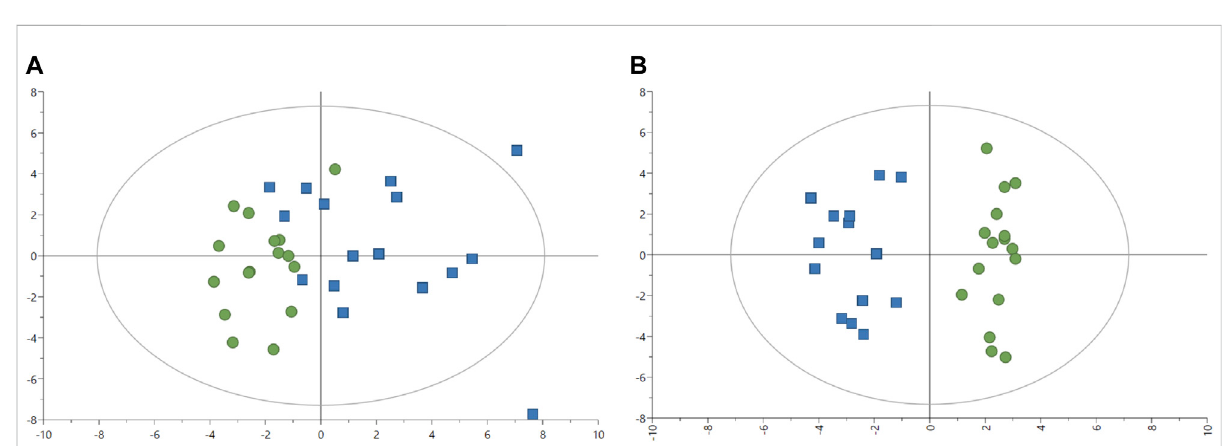
FIGURE 2 Image (A) Score plot of principal component analysis (PCA) model of 1 H-NMR data plasma ( n = 32). Green circles: fi sh-fed control feed. Blue squares: fi shfedwithexperimentalfeed.PCAscoreplot(allplasmadata,with2 PCs)withparameters:R 2 X=16.4%,R 2 X2=13.4%,Q 2 X=1.74%.Image (B) Score plot of an orthogonal partial least squares-discriminant analysis (OPLS-DA) with one predictive (P1) and two orthogonal (O2) components) model of 1 H-NMR data plasma. Green circles: fi sh-fed control feed. Blue squares: fi sh fed with experimental feed. OPLS-DA score plot (plasma samples without outliers) with R 2 X = 13.1%, Q 2 X = 79.0%, R 2 Y = 100%, CV-ANOVA = 9.02 × 10 − 07